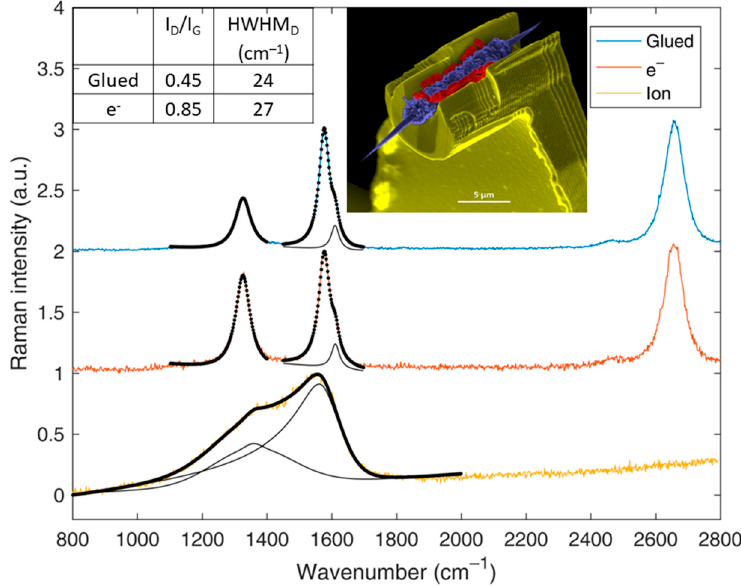
Figure 9. Raman spectra (with fitting as the heavy, black solid line) recorded on the microfiber part of three different carbon cones mounted onto an AFM cantilever (an example is provided in the inset: purple-blue is the (cone + short microfiber segment) carbon morphology; yellow is the Si-doped cantilever support; and red is the welding material, here an ion-promoted Pt deposit) by the three different procedures described in the text: bottom (blue line) Pt deposition promoted by focused ions; middle (red line) Pt deposition promoted by focused electrons; and top (yellow line) gluing with a UV-curable resin. In the top-left inset are provided the I D / I G height ratio as well as the linewidth of the D band for the two cones still exhibiting the regular D + G ( + 2D) bands. Indeed, the apex of the cone subjected to an ion beam during the mounting (blue line) has been heavily transformed and is no longer graphenic but amorphous, yet it does not show up as low magnification (see the cone apex in the middle-top image showing a cone welded onto the Si-doped cantilever support).